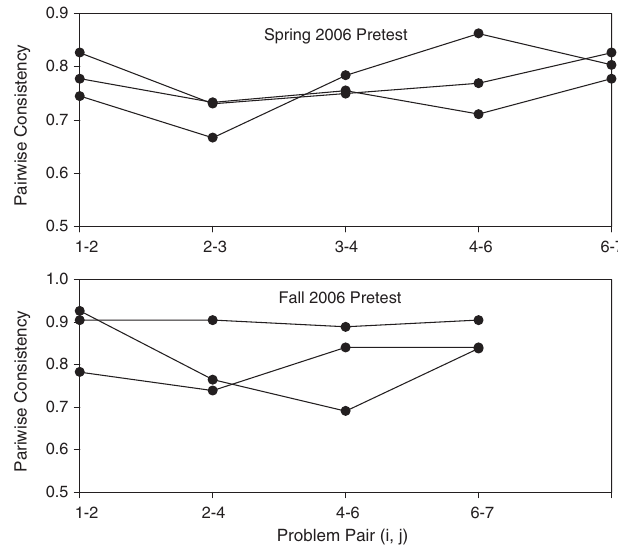
FIG. 2. Consistency of student response to pretest questions with question 5 from Spring 2006 and questions 3 and 5 from Fall 2006